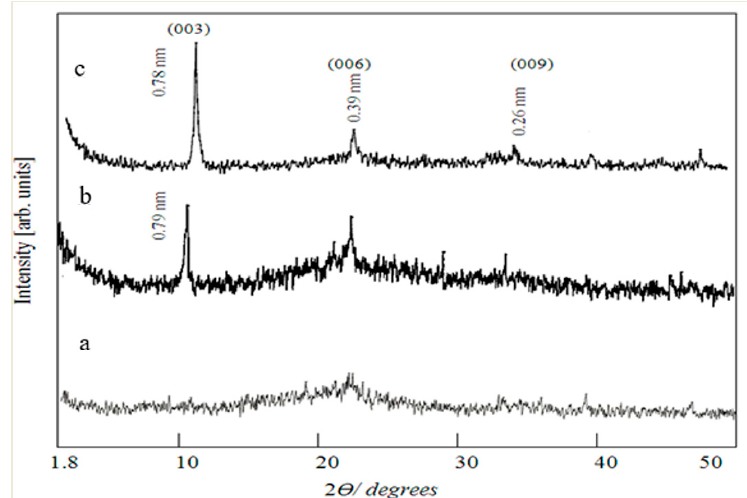
Figure 4. X-ray diffraction of Co–Si LDHs: ( a ) pure, ( b ) after zirconium inclusion, and ( c ) after zirconium and titanium inclusion.